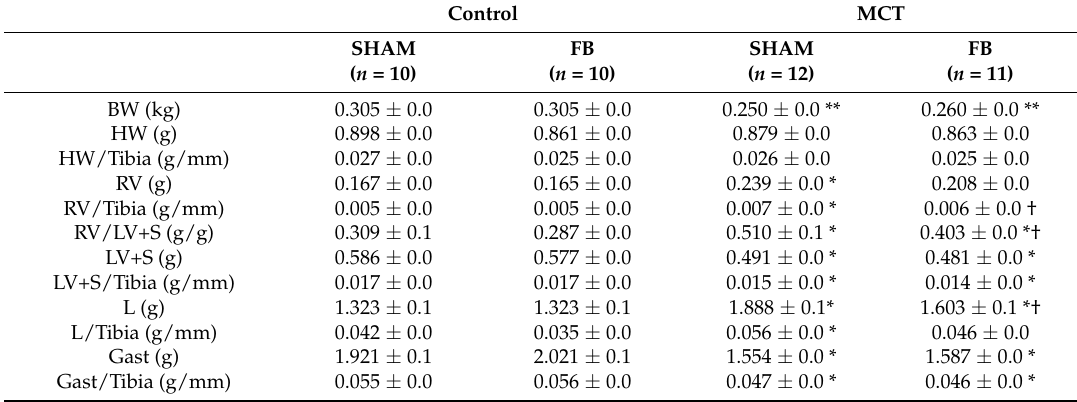
Table 1. Xanthohumol-fortified beer (FB) effects on general morphometric characteristics in healthy controls and monocrotaline (MCT) treated